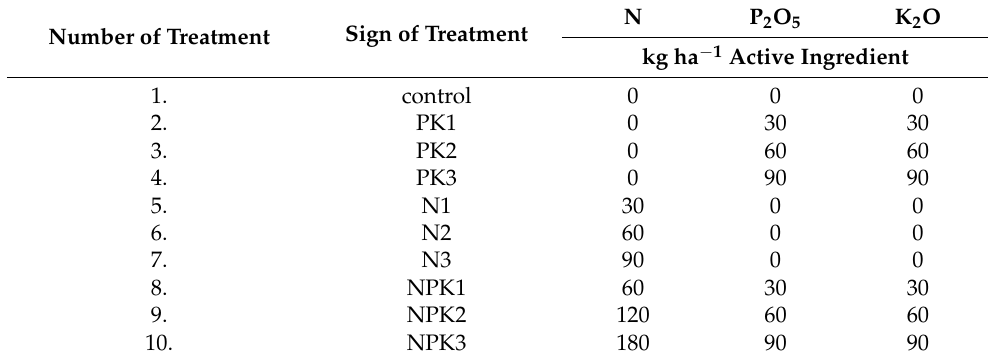
Table 1. Nutrient treatment levels of long-term experiment in Fülöpsz á ll á s. Number of Treatment Sign of